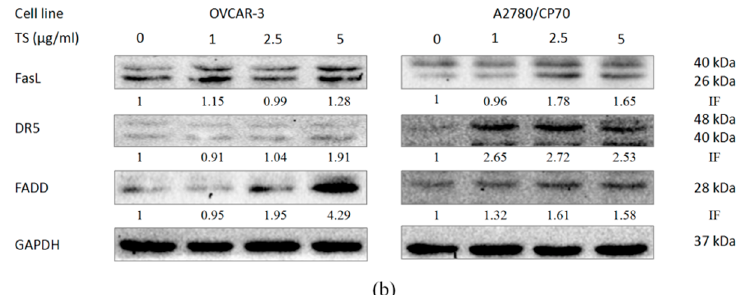
Figure 4. Effects of TS on the intrinsic apoptotic pathway and extrinsic apoptotic pathway in OVCAR-3 and A2780/CP70 cells. ( a ) The intrinsic apoptotic pathway related protein expression levels of Bad, Bcl-2, Bcl-xL, and pro-caspase-9 with 0 to 5 µ g/mL TS treatment for 24 h by Western blotting; ( b ) The extrinsic apoptotic pathway-related protein expression levels of FasL, DR5, and FADD after 0 to 5 µ g/mL TS treatment for 24 h by Western blotting. “IF” means impact factor and represents the Western blotting signals were quantified and normalized to the loading control GAPDH.